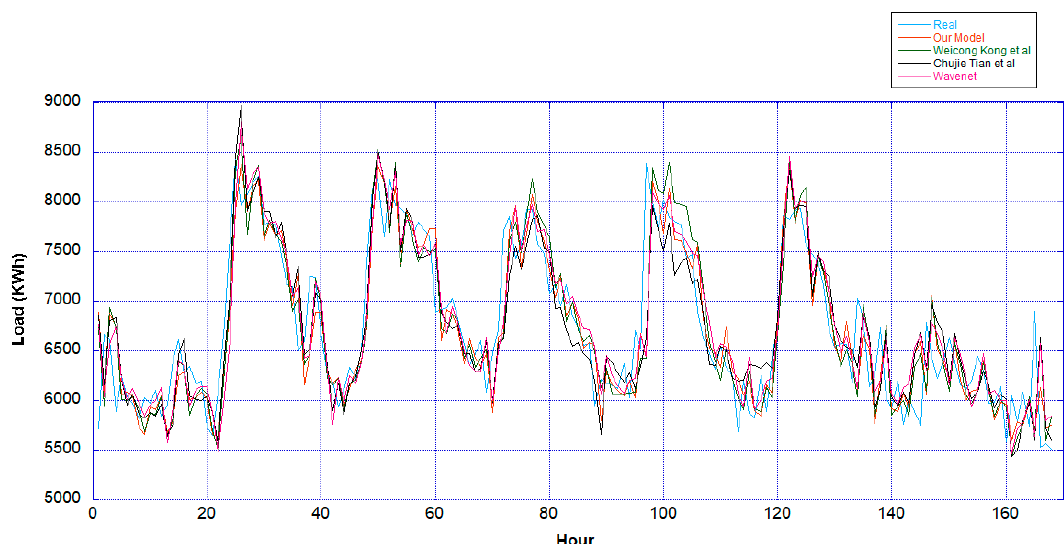
Figure 10. Forecasting result using ENTSO-E dataset 2.